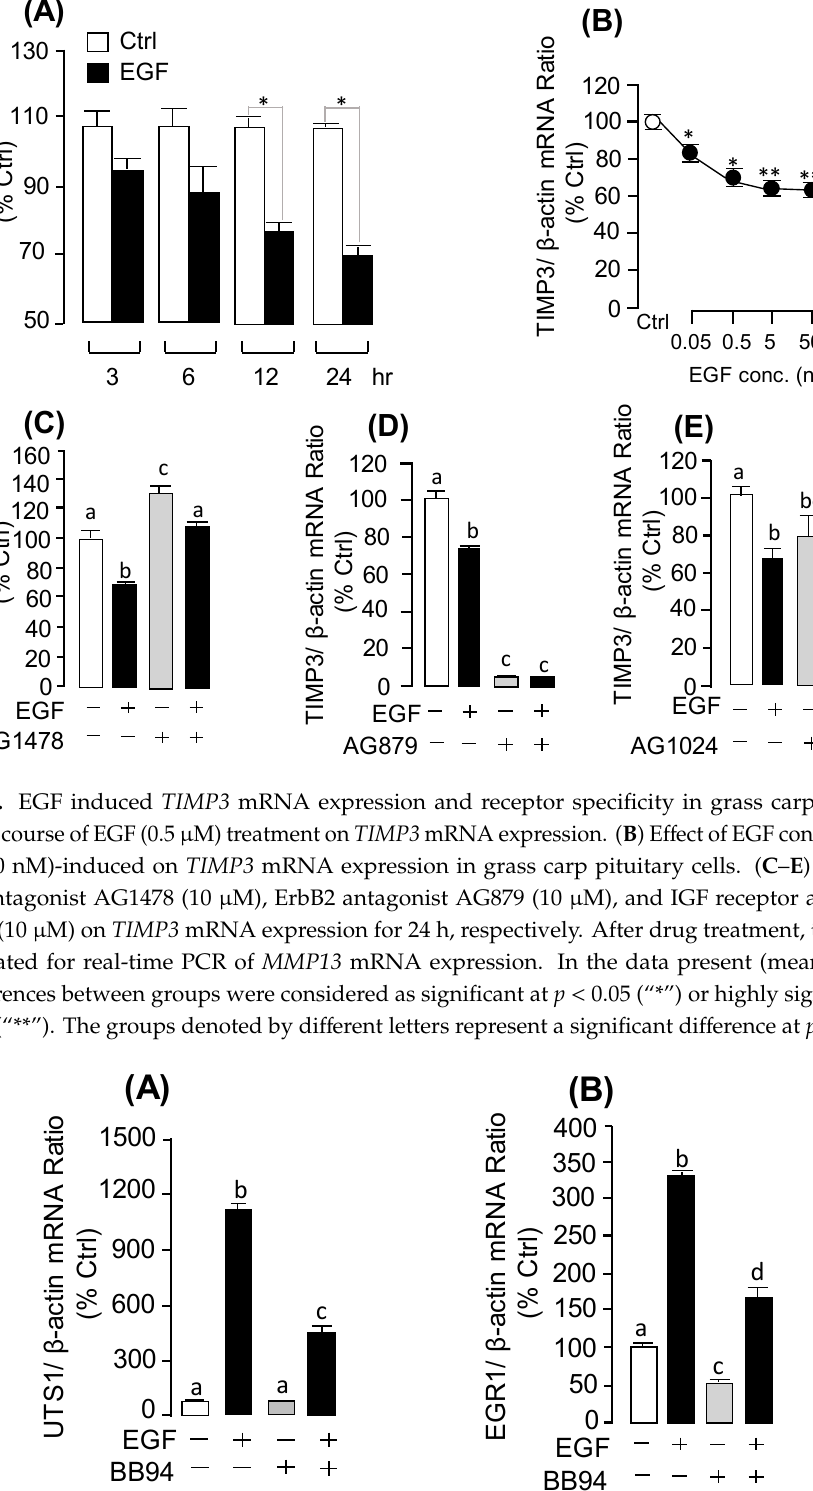
Figure 7. The functional role of in EGF-induced UTS1 and EGR1 in grass carp pituitary. ( A ) Effect of the inhibitor of MMPs BB94 (10 μ M) on UTS1 mRNA expression. ( B ) Effect of the inhibitor of MMPs BB94 (10 μ M) on EGR1 mRNA expression. After drug treatment, total RNA was isolated for real-time PCR of UTS1 and EGR1 mRNA expression. In the data present (mean ± SEM), the differences between groups were considered as significant at p < 0.05 with different letters.